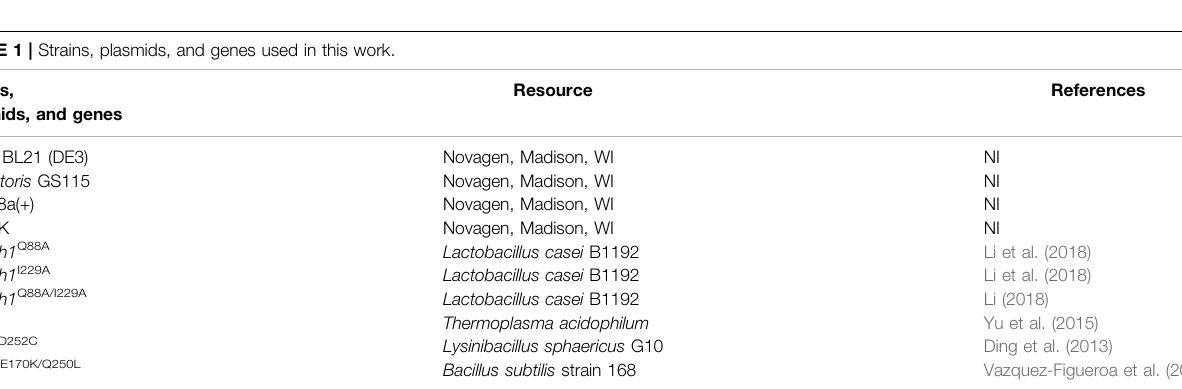
TABLE 1 | Strains, plasmids, and genes used in this work. Strains, plasmids, and genes